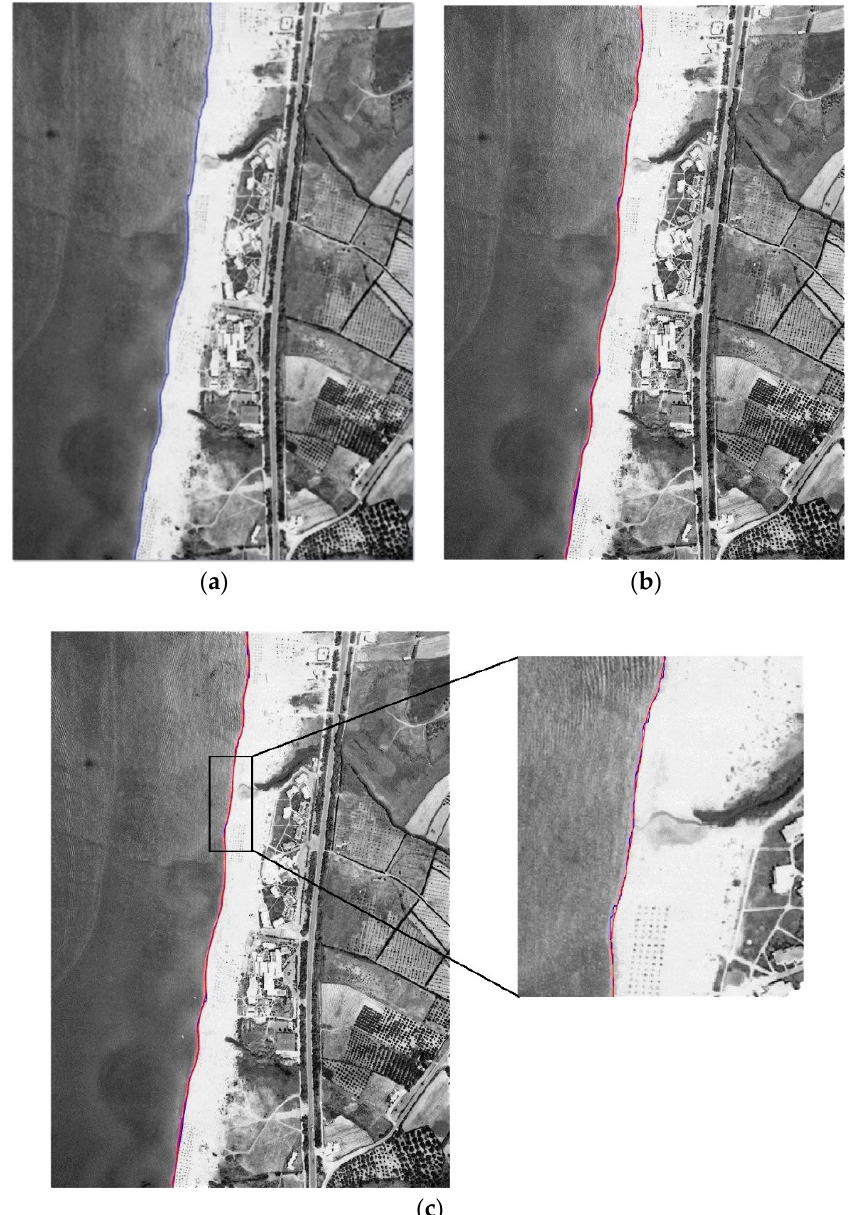
Figure 8. The results of our two methods, applied on aerial images. ( a ) The first estimation of the coastline, blue line, ( b ) line modeling with the red line, compared to the first estimation, and ( c ) the two results